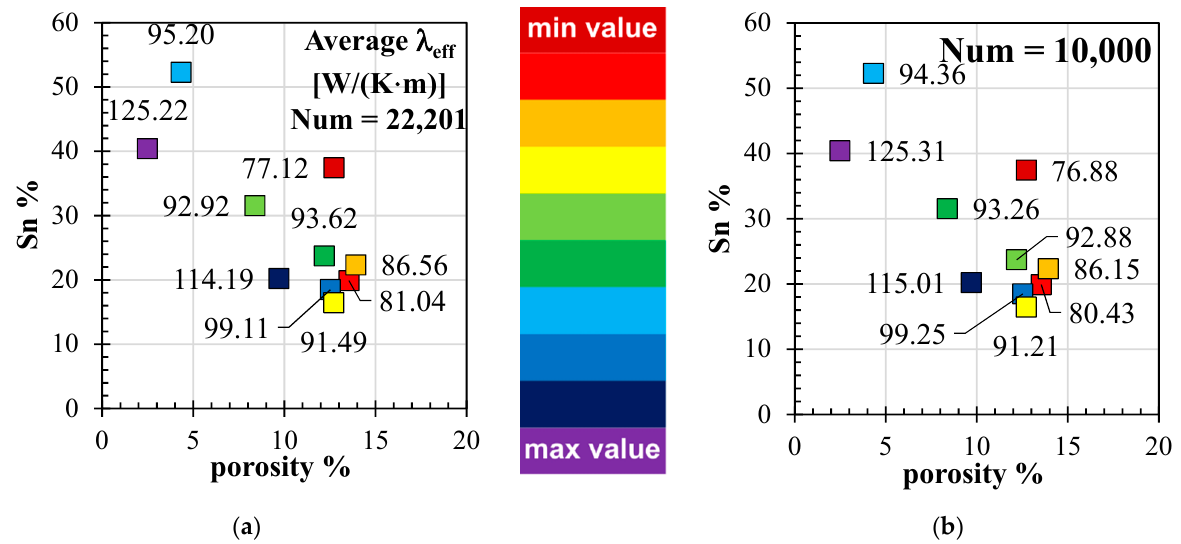
Figure 6. Average effective thermal conductivity (values next to datapoints). The color should help to order values from a minimum to a maximum. ( a ) Results with the number of particles ( Num ) equal to 22,201. ( b ) Results with the number of particles ( Num ) equal to